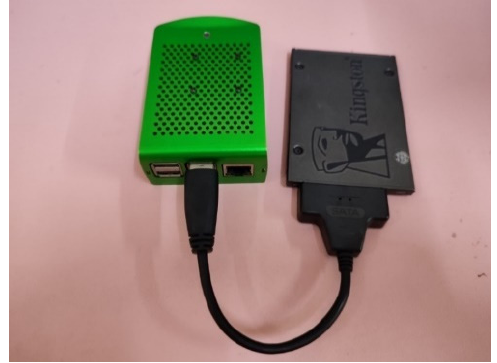
Figure 5. External SSD connected to a Pi